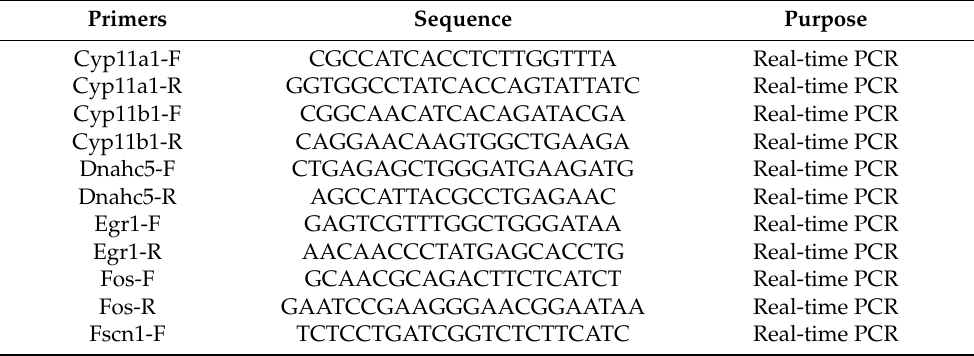
Table 1. Oligonucleotides used in this